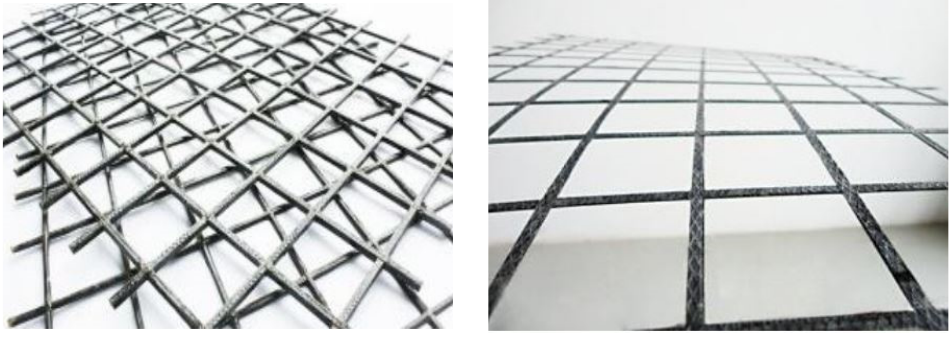
Figure 2. The FRP